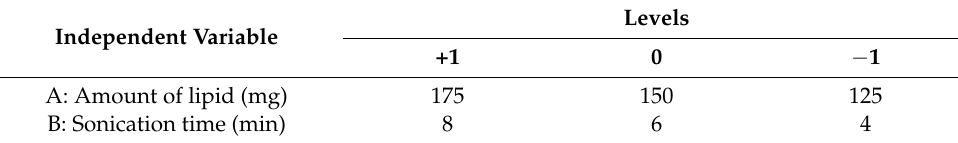
Table 3. Coded and actual values of independent variables of 3 2 full factorial